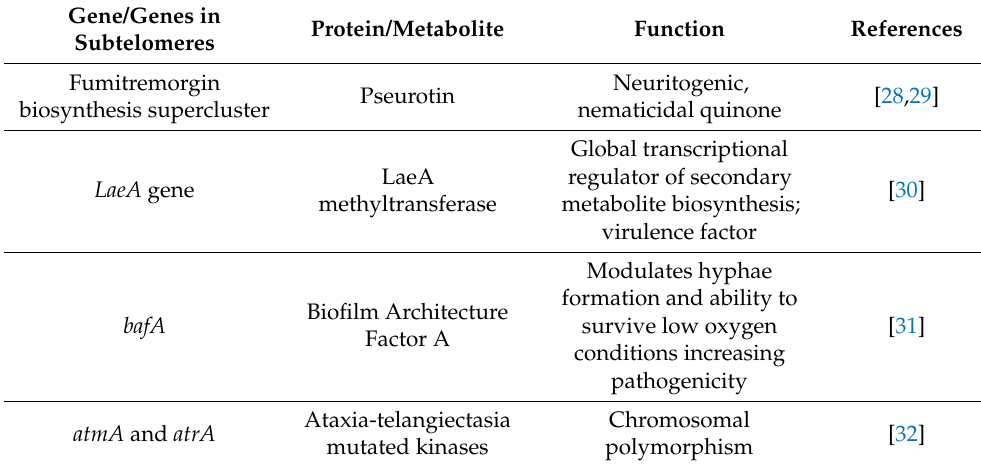
Table 2. Subtelomeric gene cluster members that increase pathogenicity in A. fumigatus